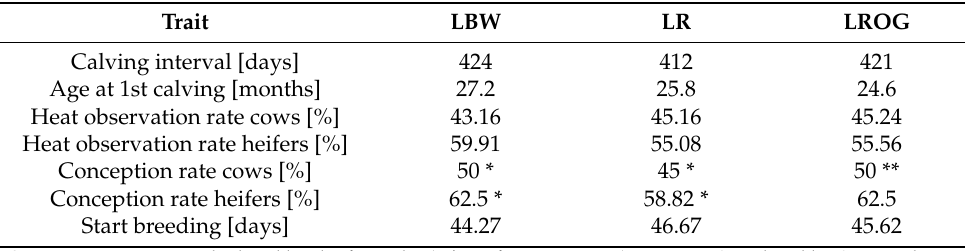
Table 4. Mean values of reproduction traits assumed for LBW, LR and LROG. Trait LBW